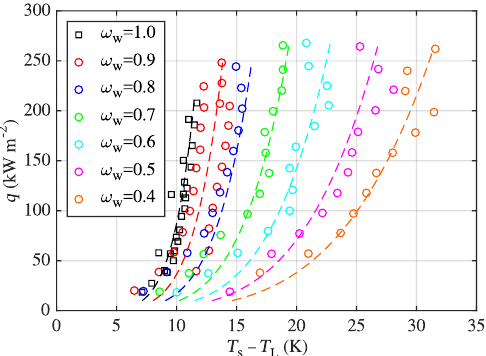
Figure 5. HTCs measured for pool boiling of water–glycerin mixtures at atmospheric pressure and their comparison with correlation (8) and with experimental data of Sarafraz and Peygham- barzadeh [31] and Sternling and Tichacek [37].